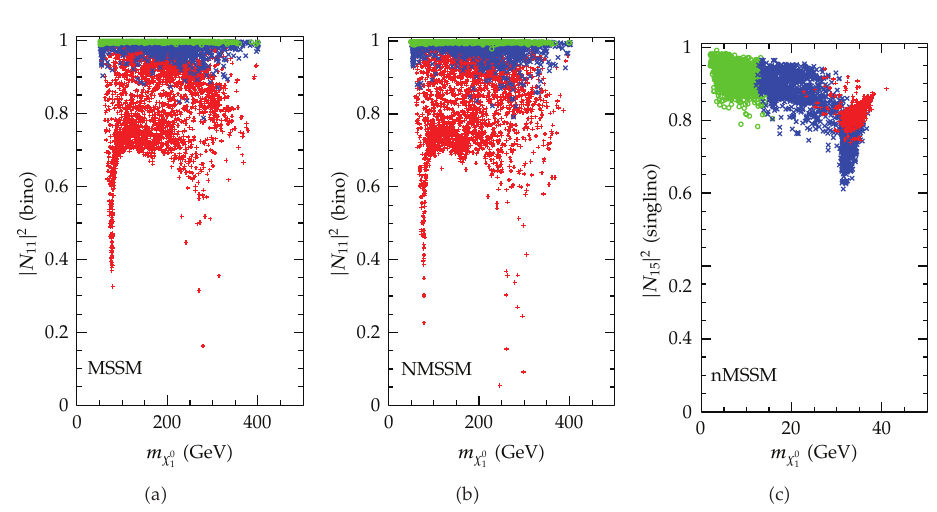
Figure 2: Same as Figure 1, but projected on the plane of | N 11 | 2 and | N 15 | 2 versus dark matter mass (cid:2) taken for (cid:5) 46 (cid:6)(cid:3) .